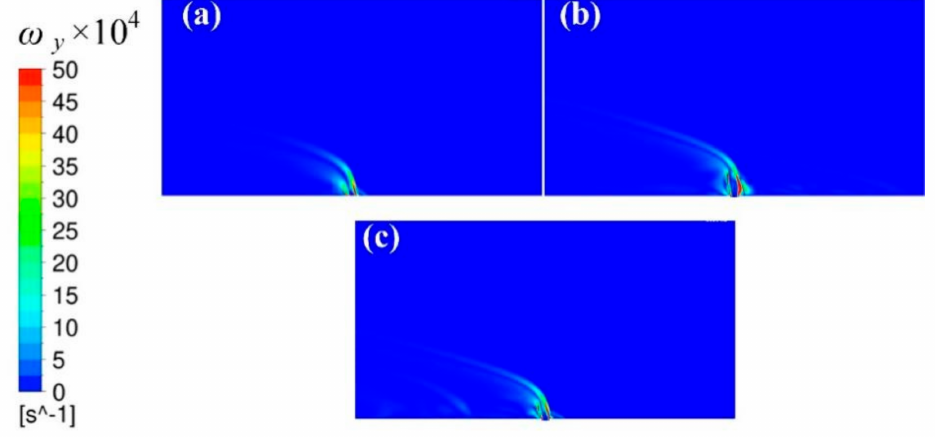
Figure 21. Intensity of the spanwise vortexes diagram at y = 0 mm for ( a ) Case a, ( b ) Case b, and ( c ) Case